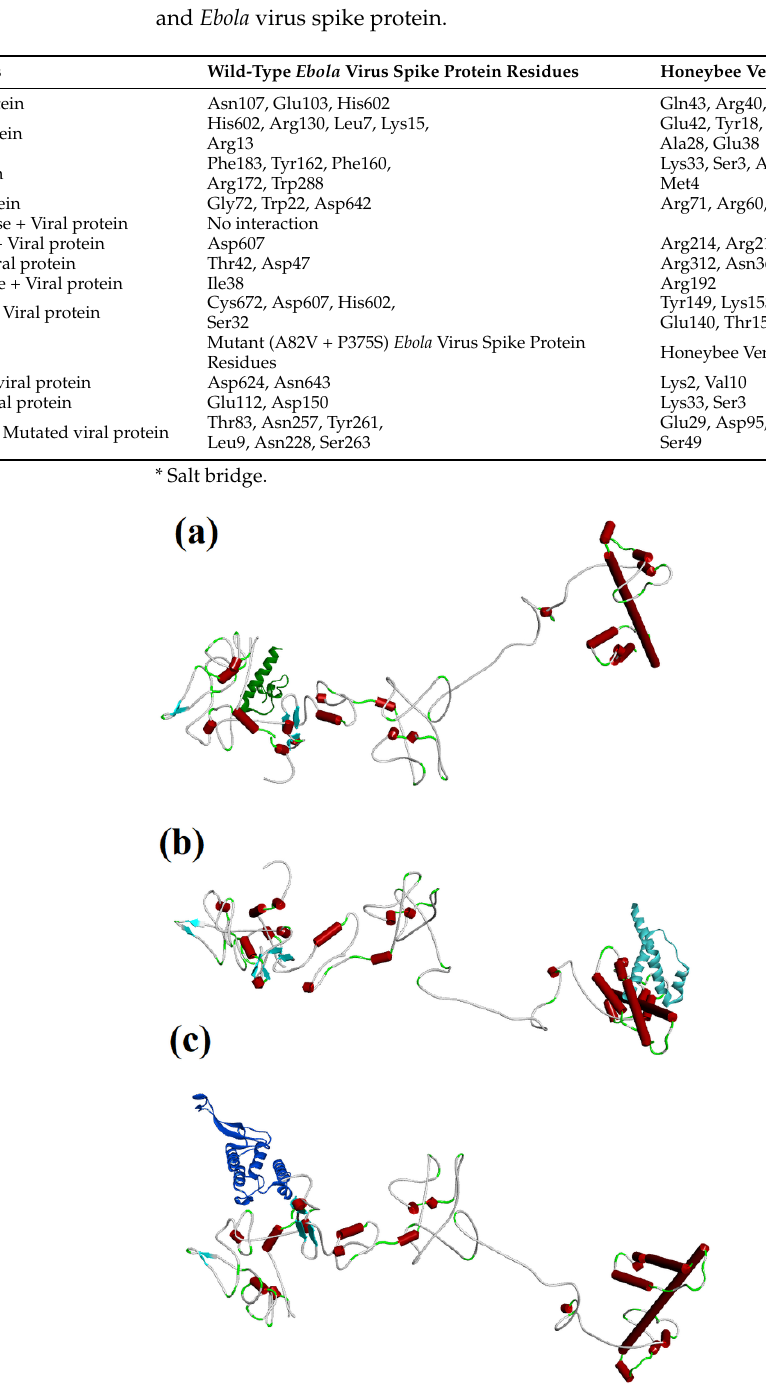
Figure 5 . Interaction of honeybee venom peptides ( a ) melittin and ( b ) MCD and protein ( c ) phospholipase A2 with mutated (A82V + P337S) Ebola viral spike protein.